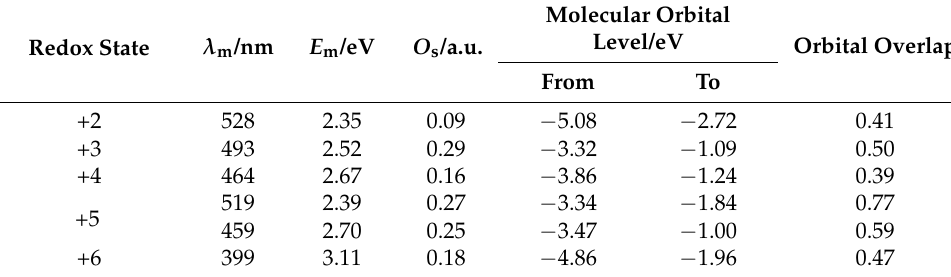
Table 2. Absorption wavelength λ m , excitation energy E m (reference to vacuum electron level), oscillator strength O s , molecular orbital energy level and overlap in characteristic optoelectronic transitions of CTTC molecule under different redox states. Molecular Orbital Level/eV Orbital Overlap Redox State λ m /nm E m /eV O s /a.u. From